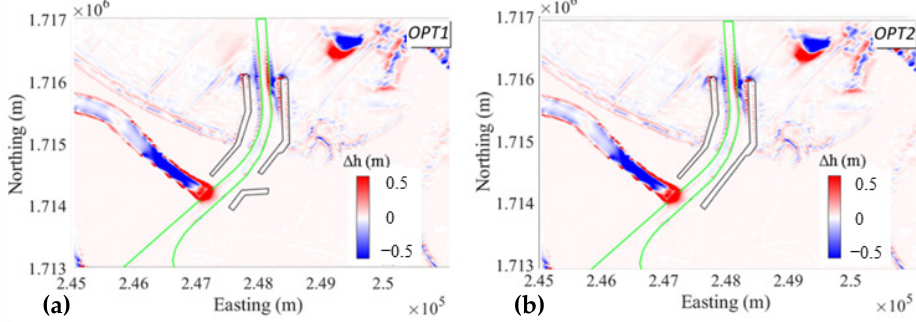
Figure 23. Bed level changes in the area of Cua Lo after the flood event and jetty construction.